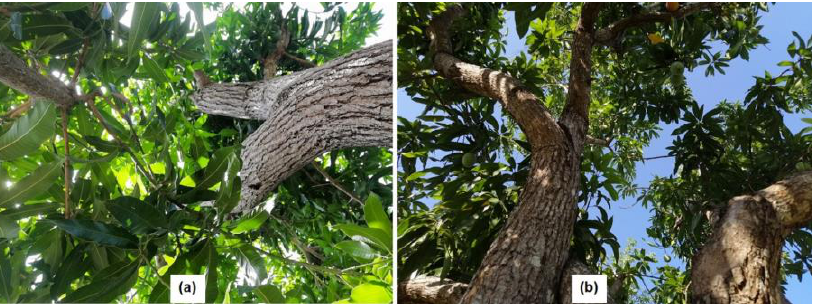
Figure 11. Mature tree viewed from the soil ( a ) before pruning in 2020, and ( b ) after harvest in 2021.